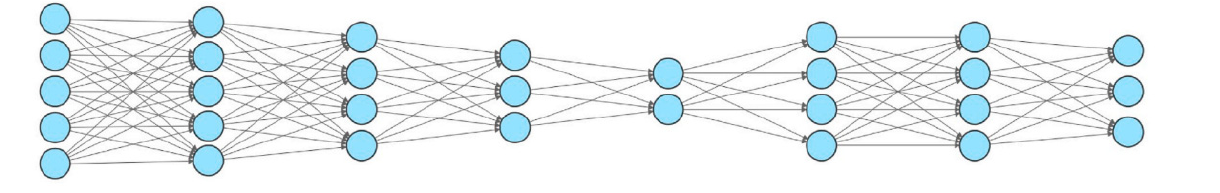
Figure 2. Convolutional neural networks (CNNs) architecture . Reproduced with permission from ref. [26]. Copyright 2020 Elsevier.